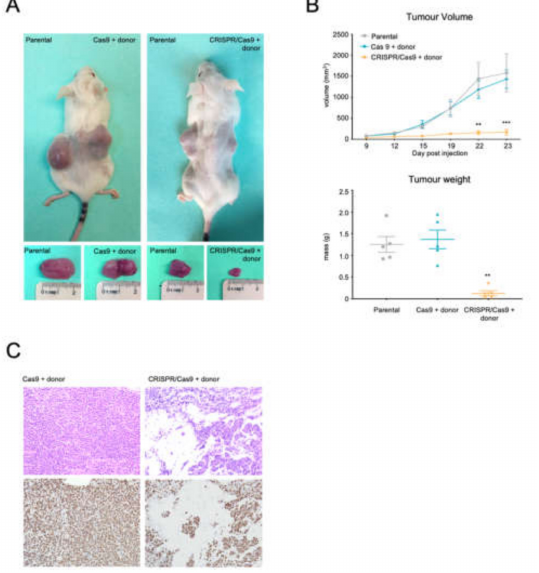
Figure 6. In vivo effects of CRISPR-trapped BCR/ABL oncogene. ( A ) External image of mice and developed tumors 23 days after subcutaneous cell injection. ( B ) Tumor growth (mm3) over the 23 days following subcutaneous cell injection. After 23 days, mice were sacrificed, and their tumor mass measured. The plots show means and SEM; ** p < 0.01, *** p < 0.001). ( C ) Histological analysis of tumors. Hematoxylin/eosin and Ki67 proliferation marker staining of tumor developed after Cas9 + donor and CRISPR/Cas9 + donor cell injection (20X